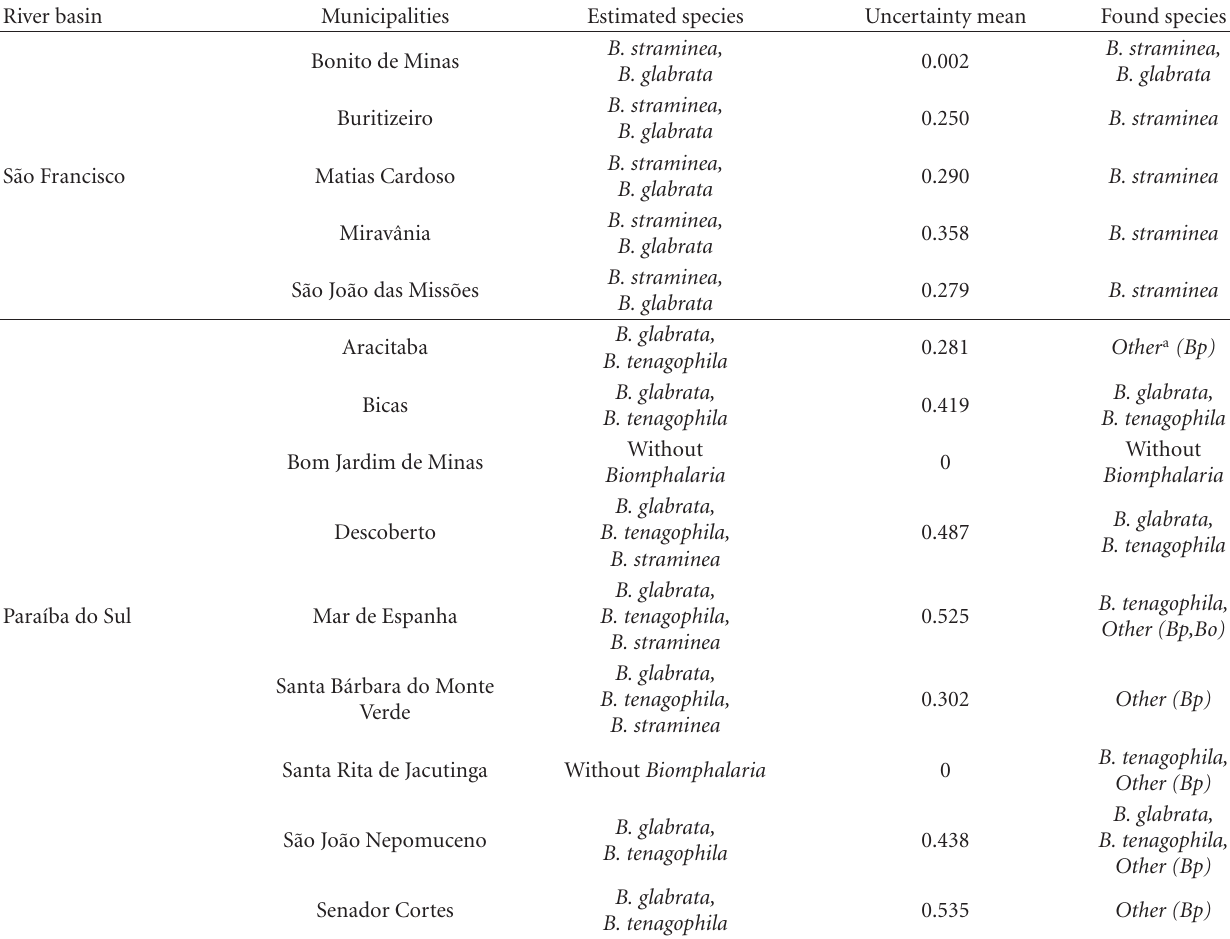
Table 1: List of surveyed municipalities and their attributes found in the San Francisco and Para´ıba do Sul River Basins (Source: [9, 18, 22]). River basin